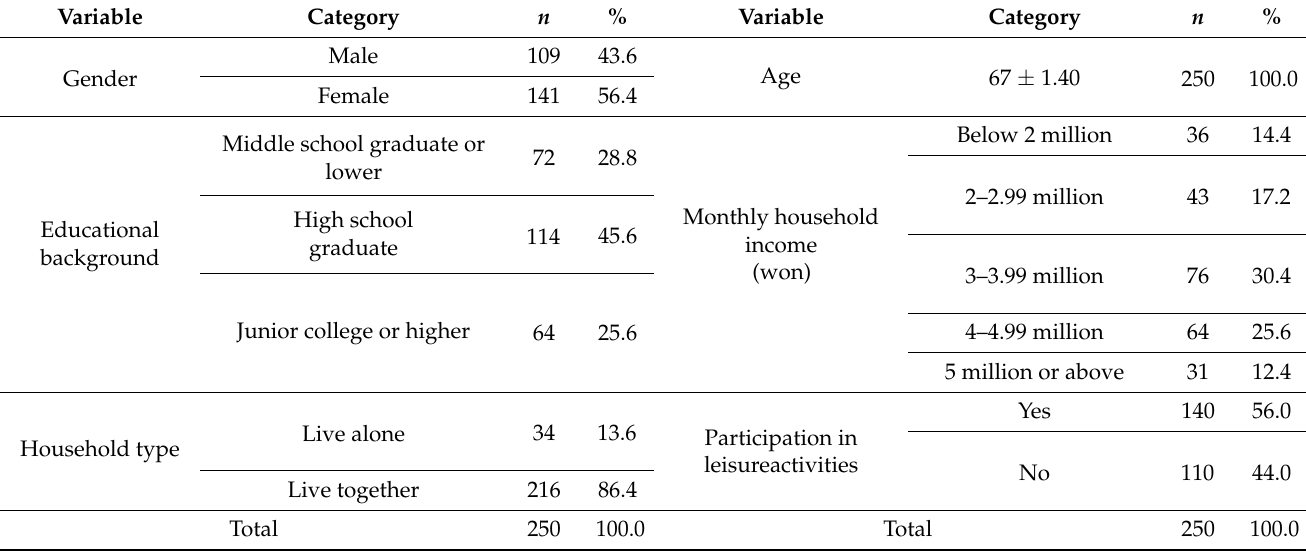
Table 1. Demographic